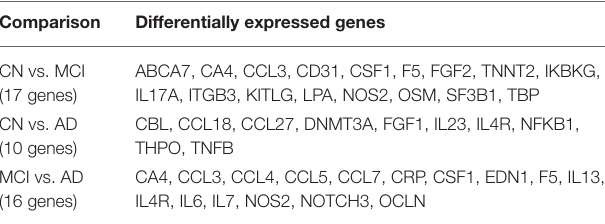
TABLE 2 | Differentially expressed genes from pairwise comparisons using National Neuroscience Institute (NNI) data. Comparison